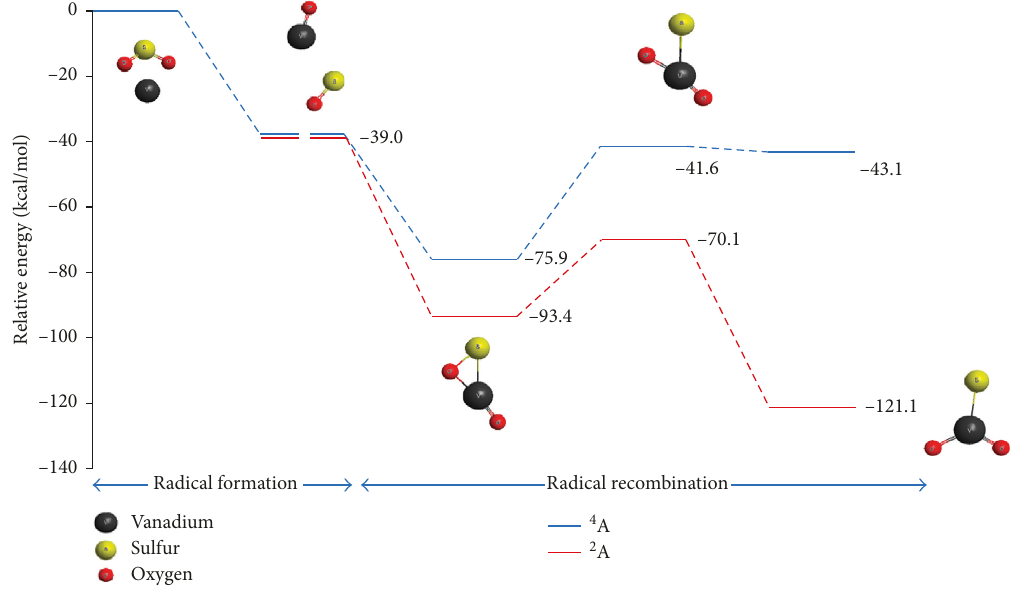
Figure 1: CASSCF-MRMP2 energy profile for the V+SO